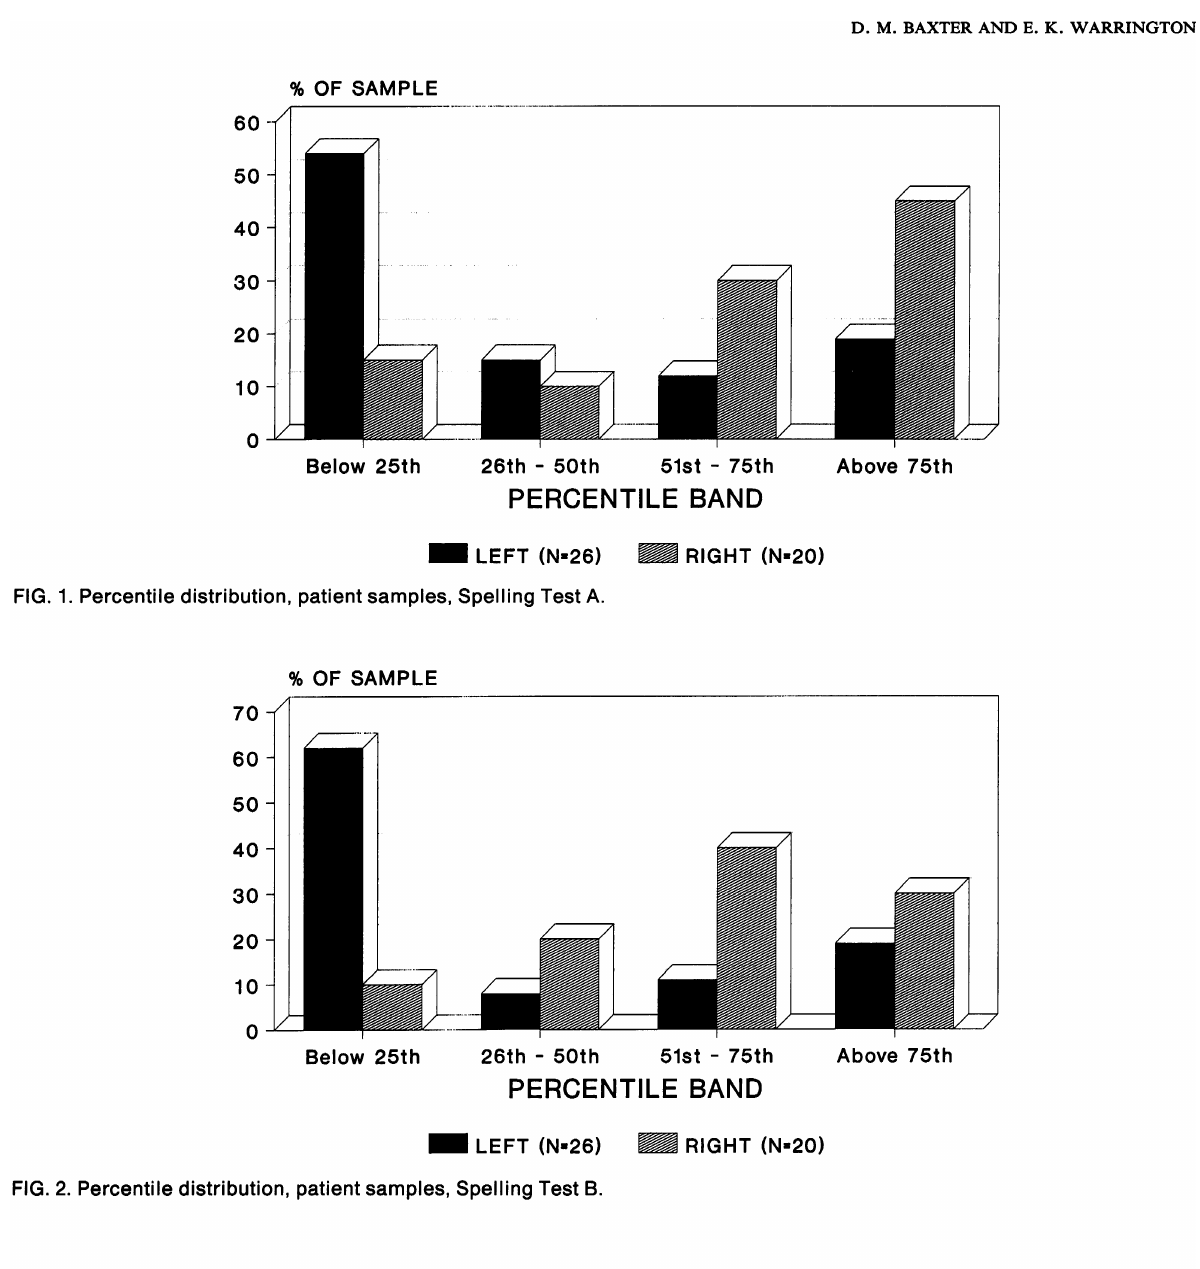
FIG. 2. Percentile distribution, patient samples, Spelling Test